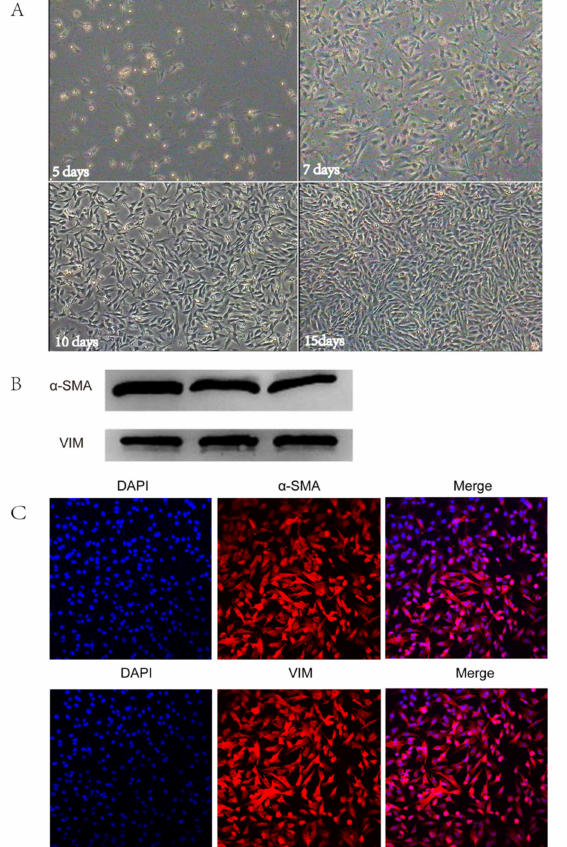
Figure 7. Isolation and identification of dermal papilla cells in vitro. ( A ) The in vitro-cultured dermal papilla cells show the growth of hair papilla cells for 5 days, 7 days, 10 days, and 15 days, respectively. ( B ) Western blotting for smooth muscle actin ( SMA ) and vimentin ( VIM ), with three repeats for each group. ( C ) Immunofluorescence staining of dermal papilla cells for α -smooth muscle actin ( α -SMA (200 × )) and VIM (200 ×